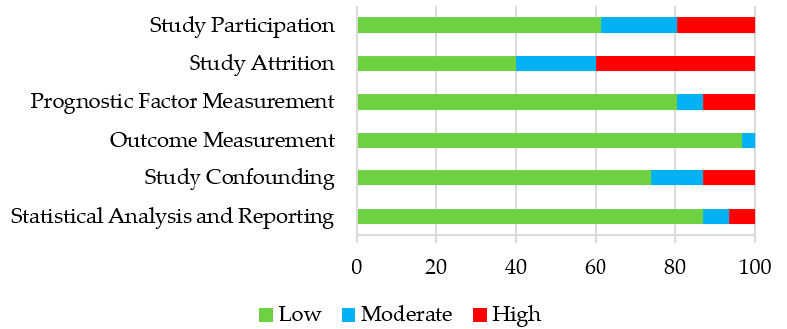
Figure 2. Percentage of included studies with a low, moderate, and high risk of bias assessed with the Quality of Prognosis Studies in Systematic Reviews (QUIPS) tool [27,28]. All the domains were assessed for all 31 studies, except the Study Attrition domain, which was assessed for five included studies.